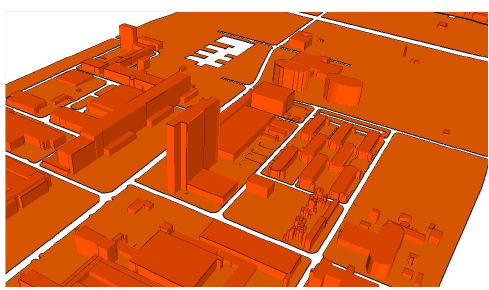
Figure 6: TU Delft campus objects. Buildings and terrain have been selected whereas the roads have been